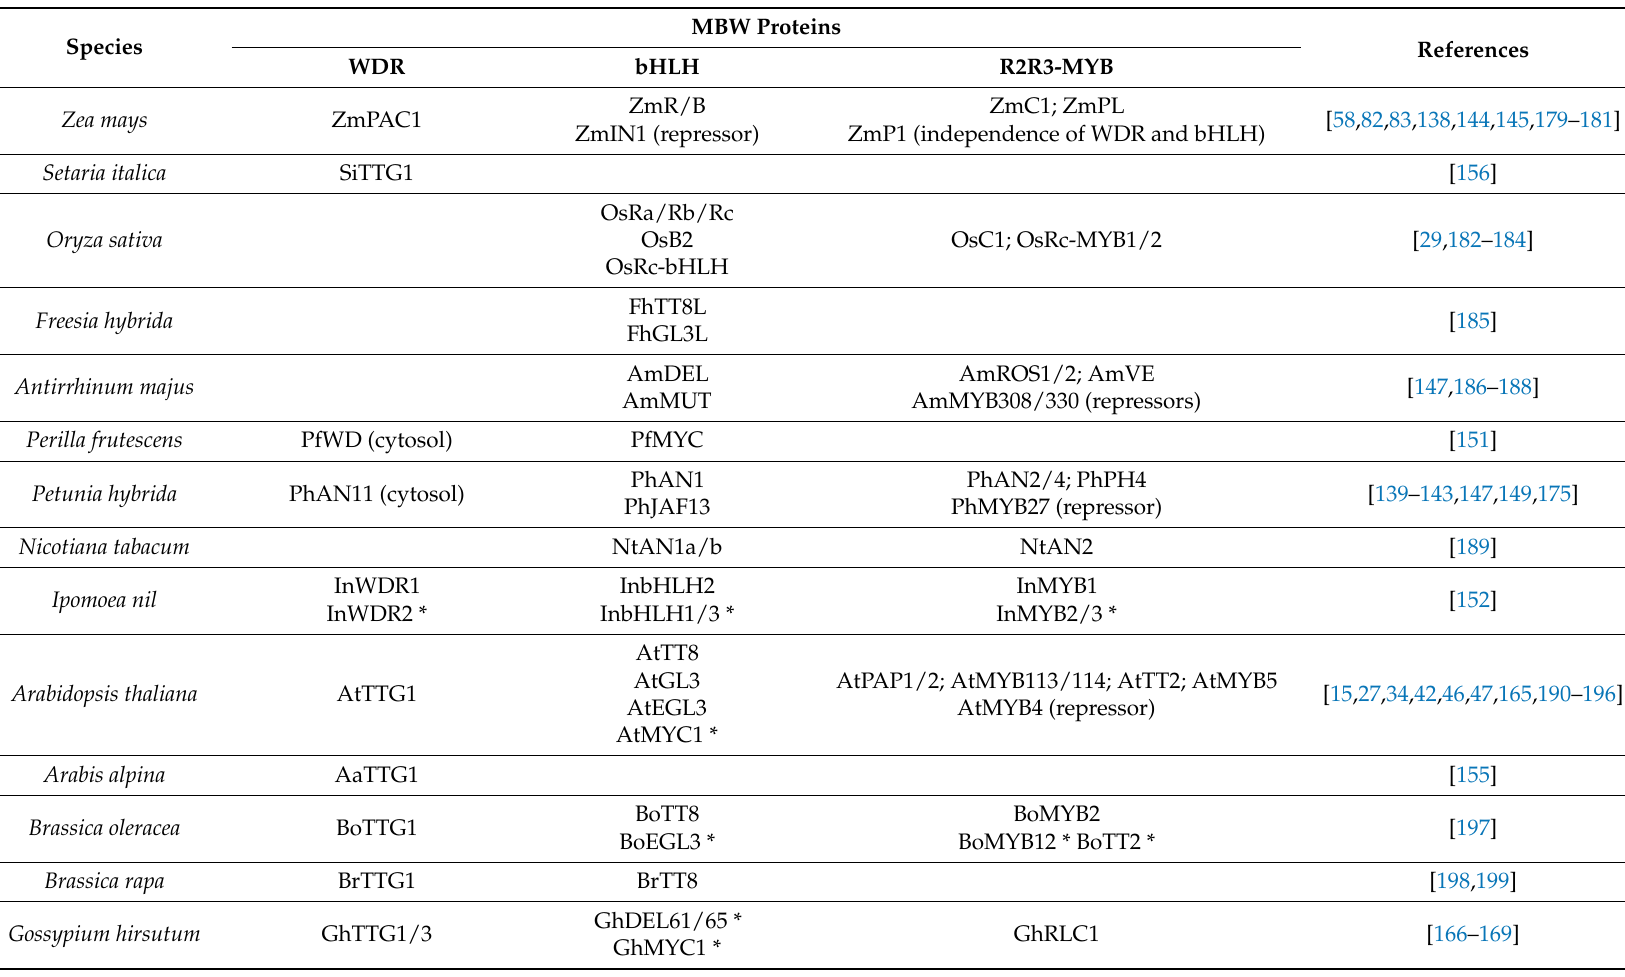
Table 2. MBW (R2R3-MYB-bHLH-WDR) proteins (putatively) regulating flavonoid biosynthesis from different plant